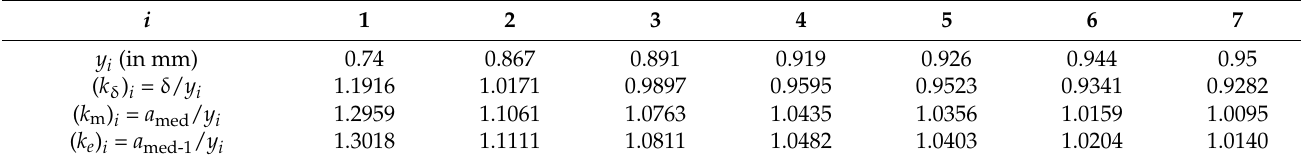
Table 11. Values of the proportionality coefficients ( k δ ) i , ( k m ) i and ( k e ) i for a pole with arm in the